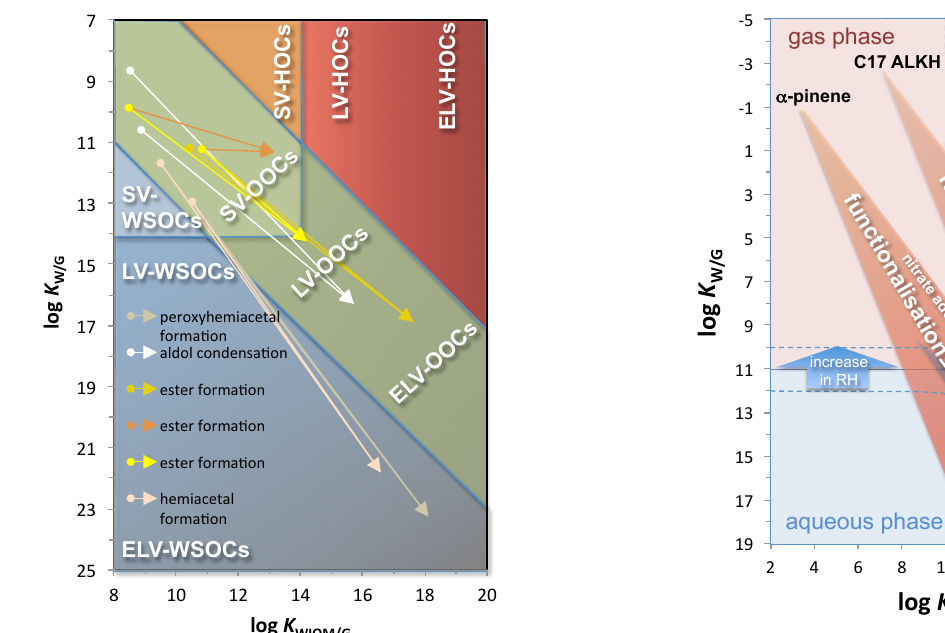
Figure 10. Displacements in the chemical partitioning space due to various dimerisation reactions proposed for ozonolysis reaction products of α -pinene by Camredon et al. (2010). K WIOM / G and K W / G at 15 ◦ C were estimates with SPARC using structure B as a surrogate for WIOM. Also shown is the categorisation into com- pounds with different atmospheric phase distribution behaviour in- troduced in Fig. 4.